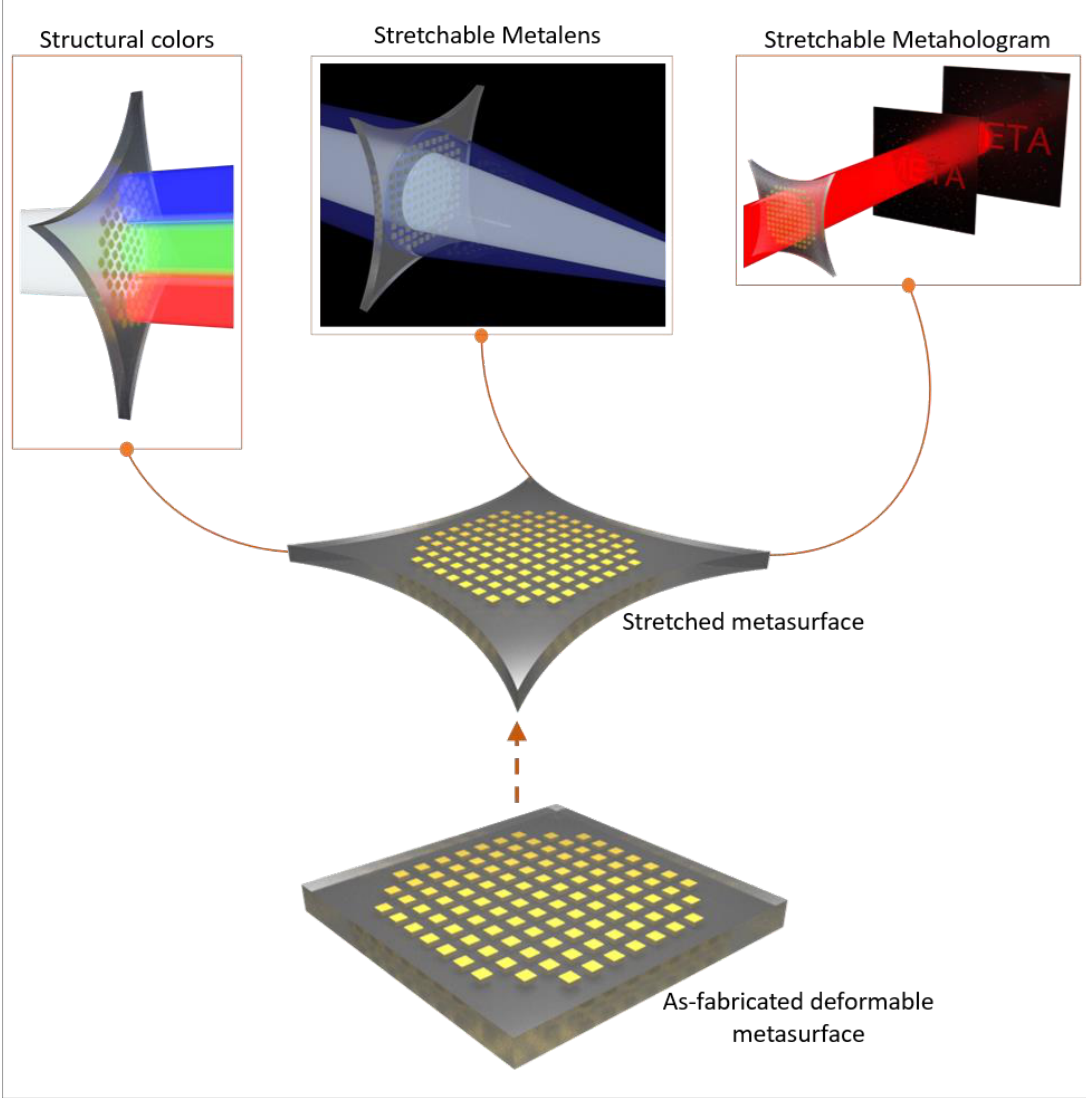
Figure 1. Deformable–Stretchable metasurfaces. The as-fabricated metasurface ( bottom ) is realized by embedding meta-atoms of varying geometries and orientations in a deformable polymeric substrate. The as-fabricated metasurface is engineered to achieve a fixed optical property including metalenses, metaholograms, structural colors, and plasmonic resonant metamaterials for various sensing applications. By stretching the metasurface ( center ), the interatomic distance of the meta-atoms changes translating into a change in optical functionality of the metasurface as showed in dynamic structural colors ( top , left ), stretchable metalens ( top , middle ), and stretchable metaholograms ( top , right